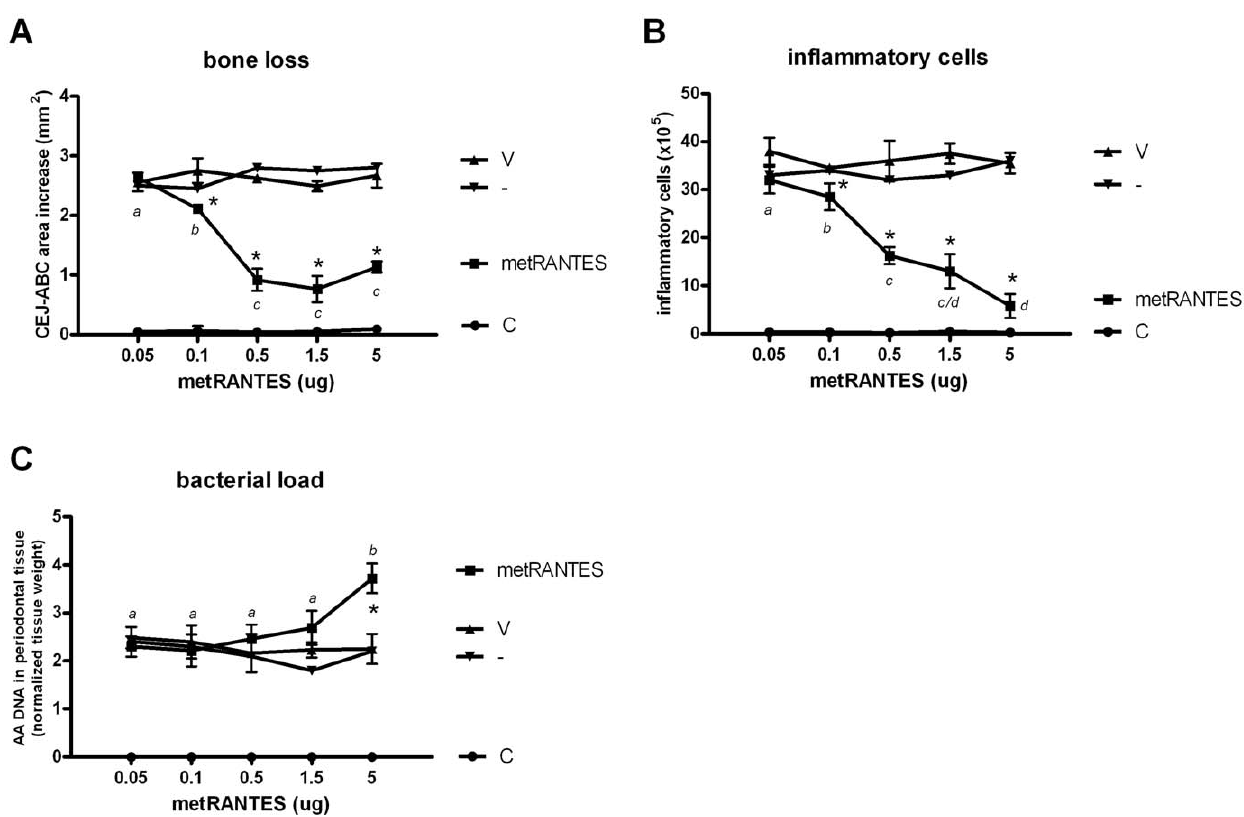
Figure 1. The effect of met-RANTES treatment at different doses in the modulation of alveolar bone loss, inflammatory cell influx and bacterial load in experimental periodontal disease. C57Bl/6 mice were infected orally with A. actinomycetemcomitans and treated with met-RANTES at 0.05, 0.1, 0.5, 1.5 and 5 mg doses or (V) veicule, (-) non treated and (C) control non-infected mice and evaluated at 30 day post- infection for: A) alveolar bone loss quantification, performed through the measurements of cement-enamel junction-alveolar bone crest (CEJ-ABC) area in the palatal face of maxillary molars; B) total leukocyte counts of inflammatory infiltrate, performed in a Neubauer chamber; and C) A. actinomycetemcomintans load (AA DNA) in periodontal tissues, quantified by Real-TimePCR, using SybrGreen System and the cycle threshold (Ct) method; all performed as described in the Material and methods; *p , 0.05 versus non-treated mice, unpaired t-test. Different italic low case letters represent statistically significant differences among the doses in the same experimental group (P , 0.05; One-way ANOVA).